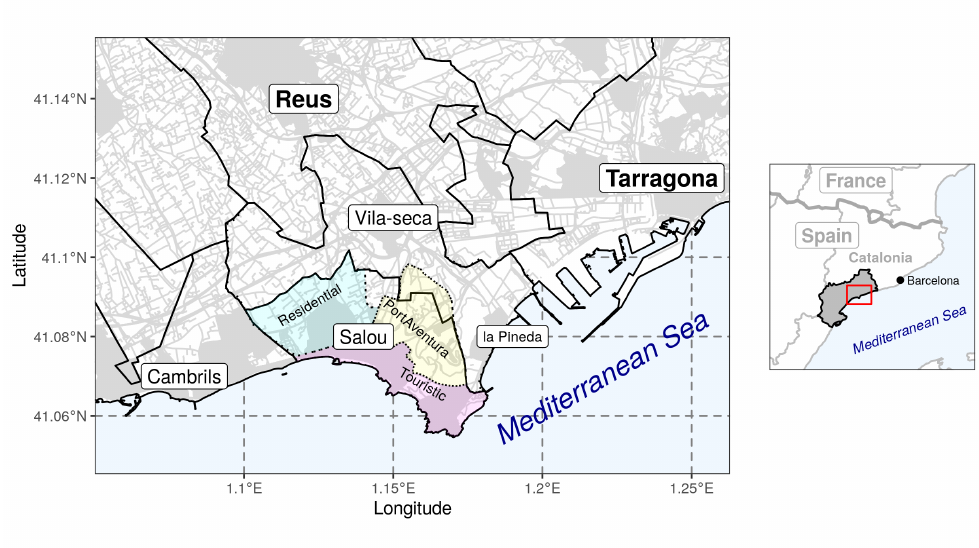
Figure 2. Location map of the study area. The main map shows the principal municipalities in the area and the proposed zoning of Salou (residential, PortAventura, and tourist areas). The reference map shows the study area in context within the province of Tarragona, Catalonia, and